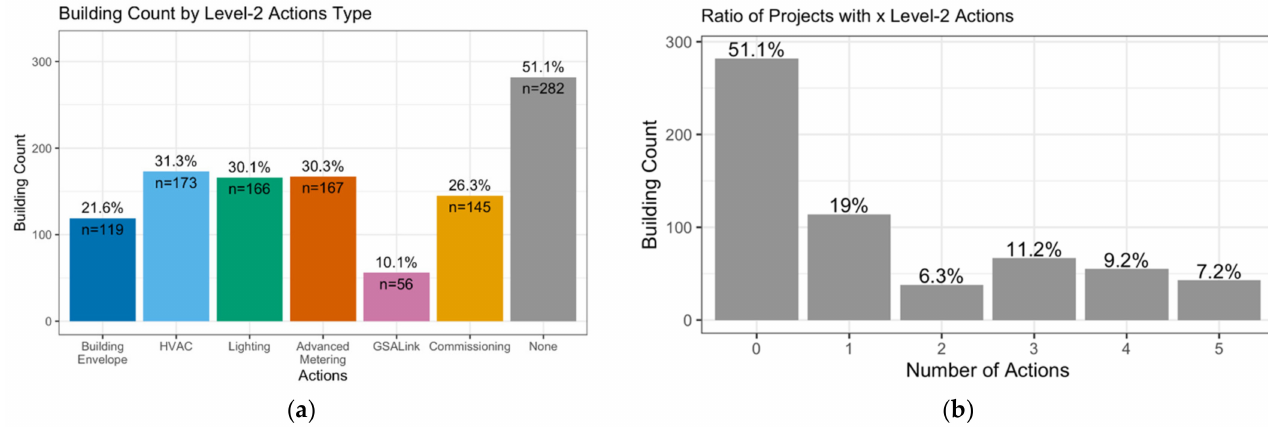
Figure 2. Retrofit building count: ( a ) percentage and number of buildings with each type of retrofit action, and ( b ) percent and number of buildings with 0 through 5 types of retrofit